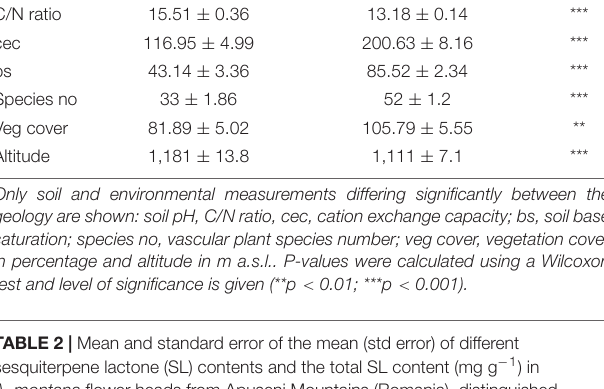
TABLE 2 | Mean and standard error of the mean (std error) of different sesquiterpene lactone (SL) contents and the total SL content (mg g − 1 )